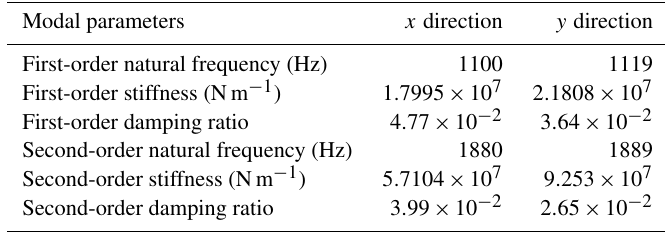
Table 2. Modal parameters of the tool.